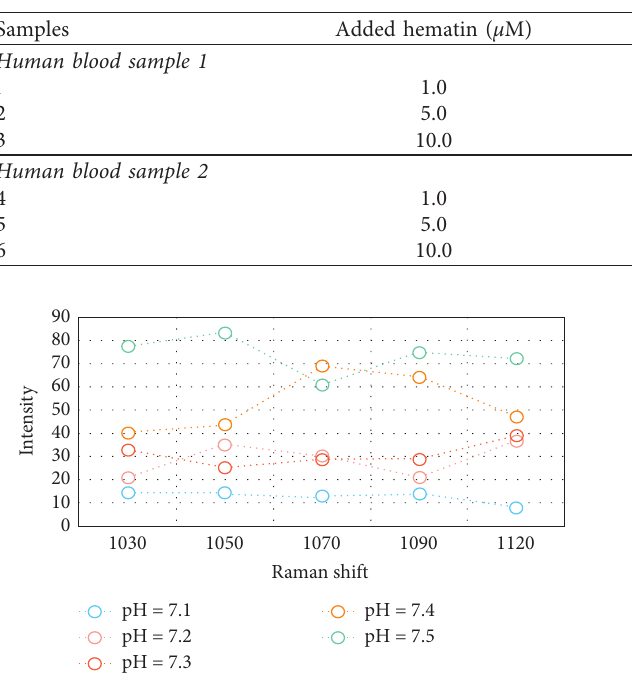
Table 2: Reproducibility and accuracy of the evaluation method.